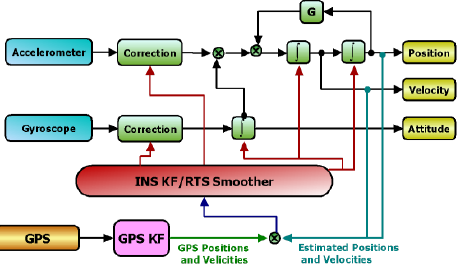
Figure 3: The integration architecture of LC (closed